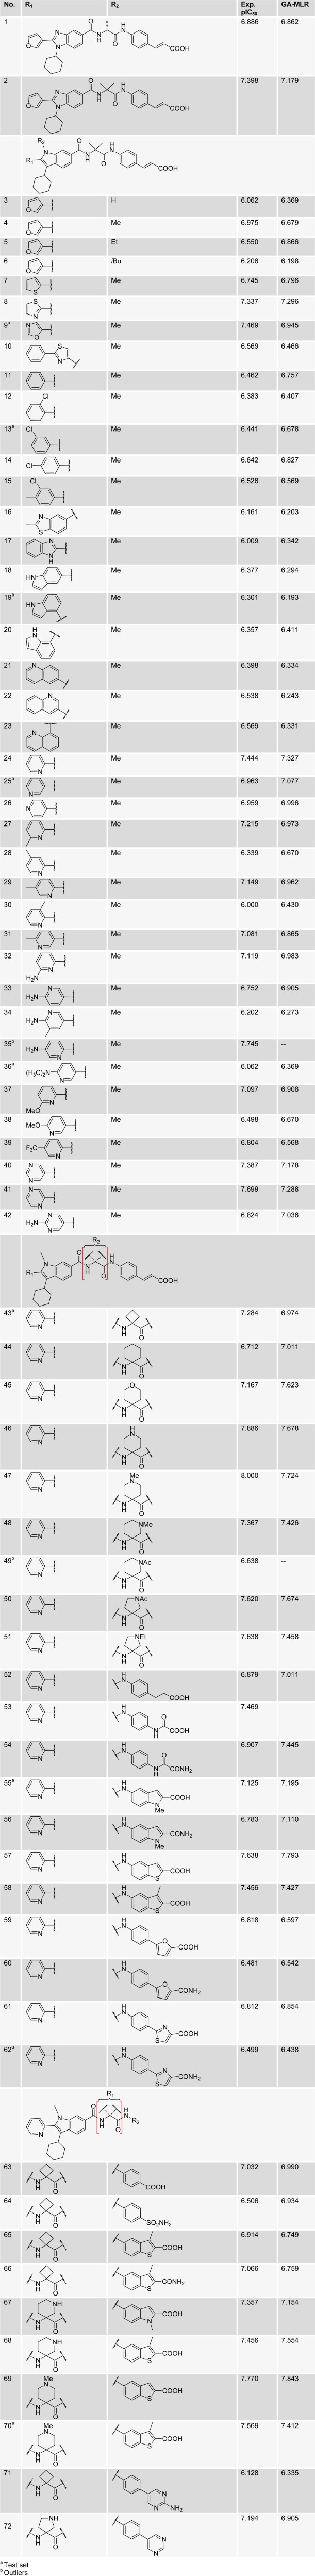
Table1: Chemical structures and the corresponding observed and predicted pIC50 values by GA-MLR method